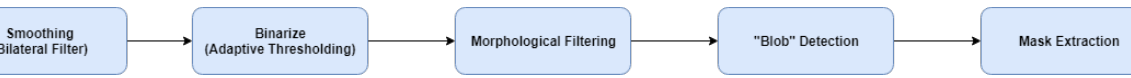
Figure 6. Image pre-processing steps for the generation of reference masks (as